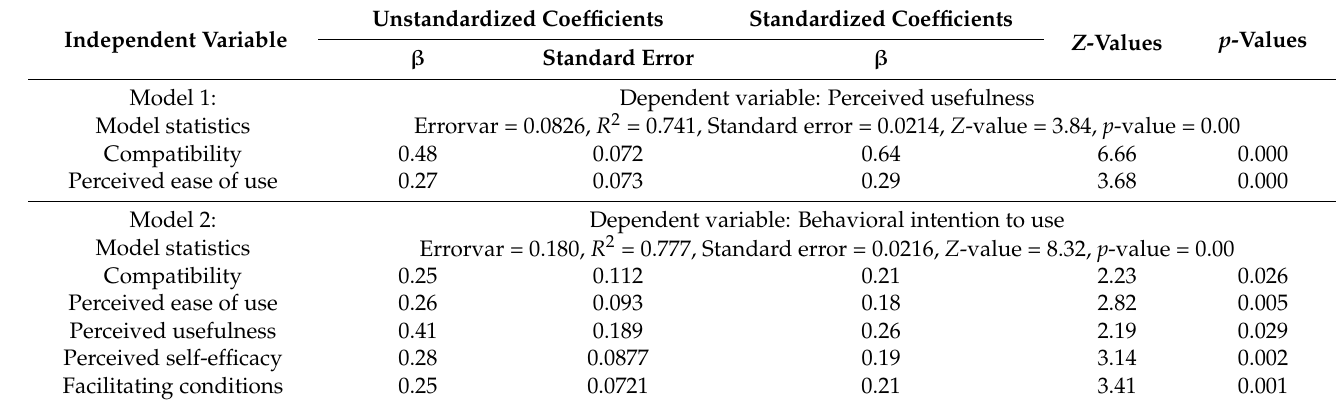
Table 5. Multiple regression analysis